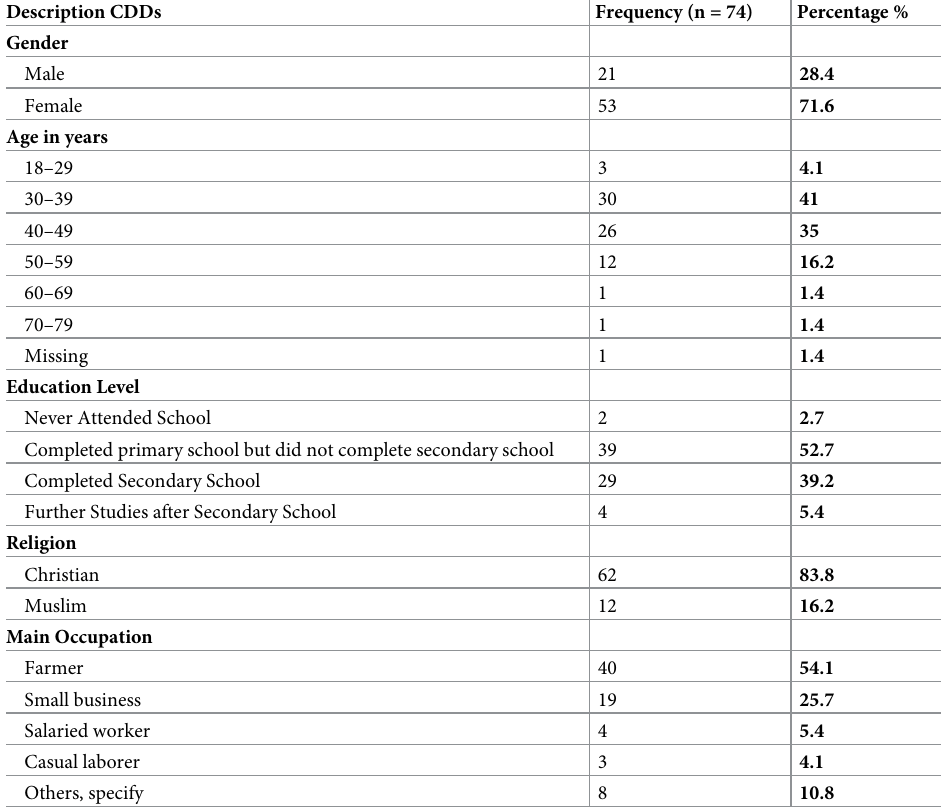
Table 1. Socio-demographic Characteristics of the Study Participants CDDs